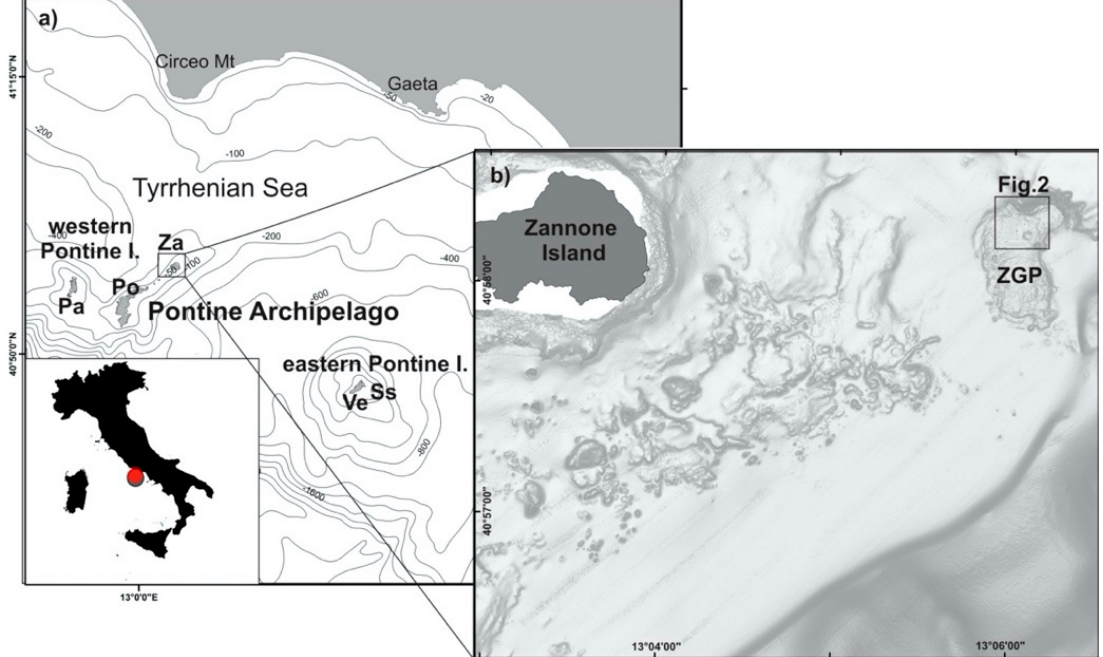
Figure 1. ( a ) Location of the Pontine Archipelago (Tyrrhenian Sea). Pa: Palmarola; Po: Ponza; Za: Zannone; Ve: Ventotene; Ss: Santo Stefano. ( b ) Shaded relief of the seafloor surrounding the Zannone Island, with the location of the Zannone Giant Pockmark (ZGP) where the seafloor samples were recovered. In the top right of Figure 1b, the rectangle identifies the area shown in Figure 2. Modified after Di Bella et al. [15].